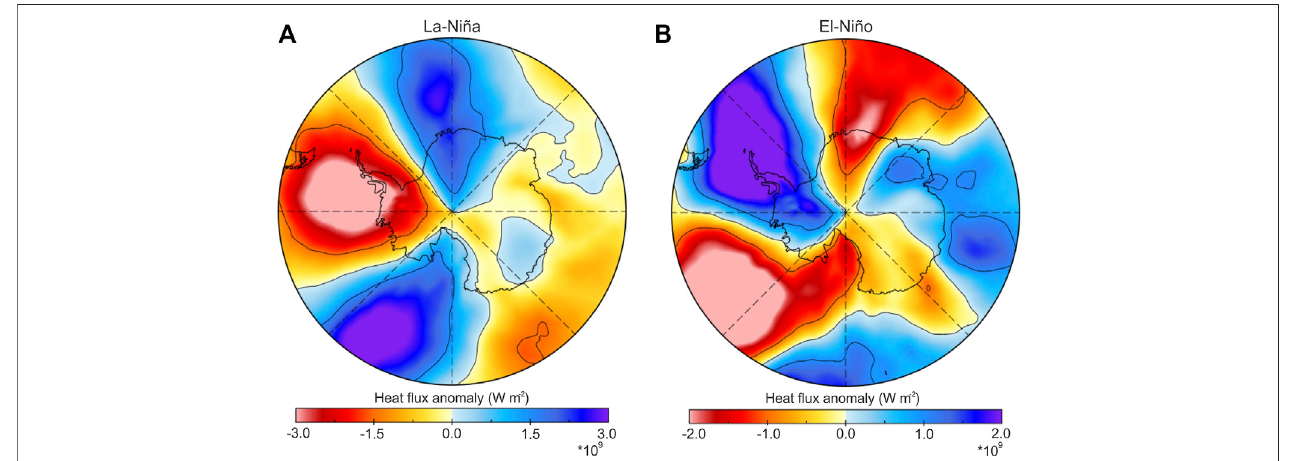
FIGURE8| Heat fl uxanomalyduringElNiñoandLaNiñayears.Panel (A) and (B) showcompositeanomalyplotsoftheERA5verticalintegralofthenorthwardheat fl ux (W m − 2 ) for the La Niña years and El Niño years respectively during 1979 – 2019 CE. The negative anomaly of the vertical integral of the northward heat fl ux (W m − 2 ) suggests heat transfer from north to south and suggests an increase in temperature over the DML region of East Antarctica and vice versa.